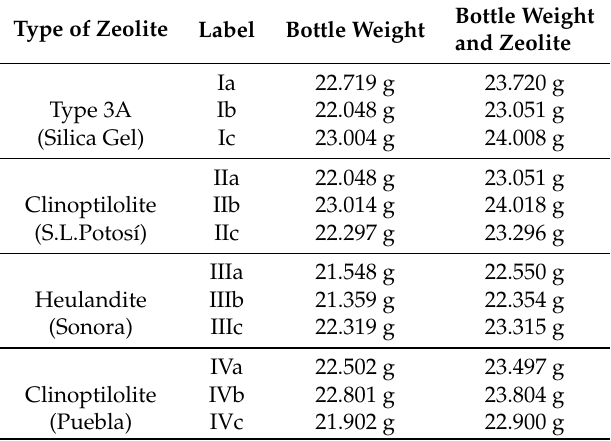
Figure A9. Measurement of the different zeolite samples. Table A7. Bottle weights and the bottle plus zeolite.